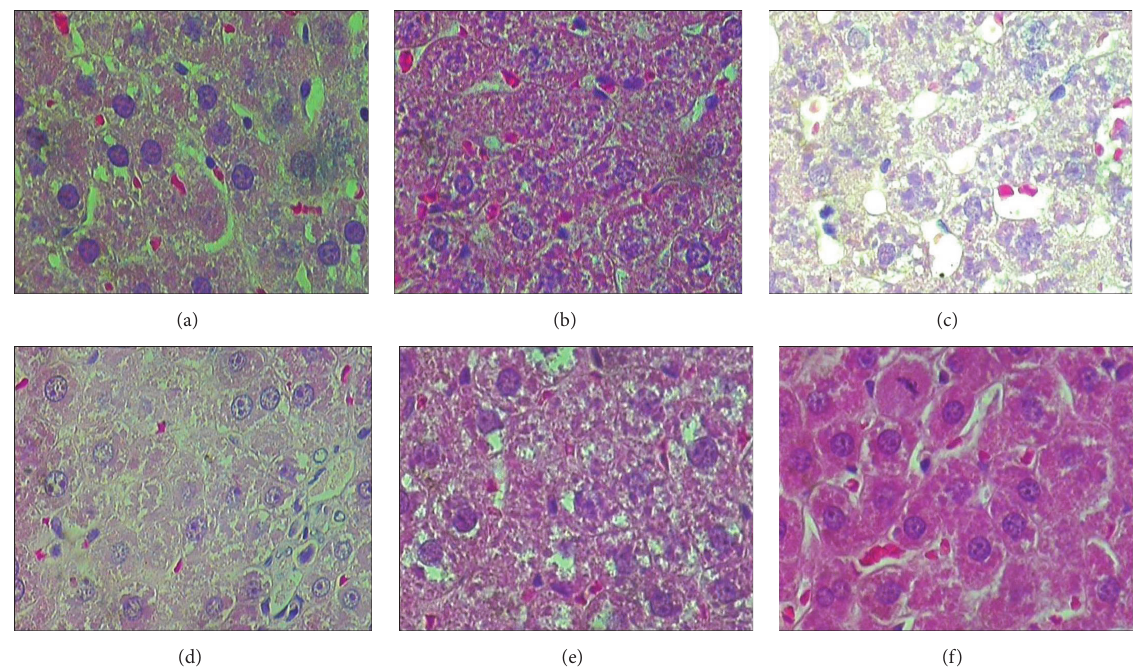
Figure2:Representativehistopathologyslides( × 20)ofratliversfromcontrol(untreated)andisoniazid(INH)treatedratsandtheirrespective pathology reports. (a) (No INH): untreated group . “ No pathology appears to be present in the control (untreated) animals ”; (b) (INH × 2 days):